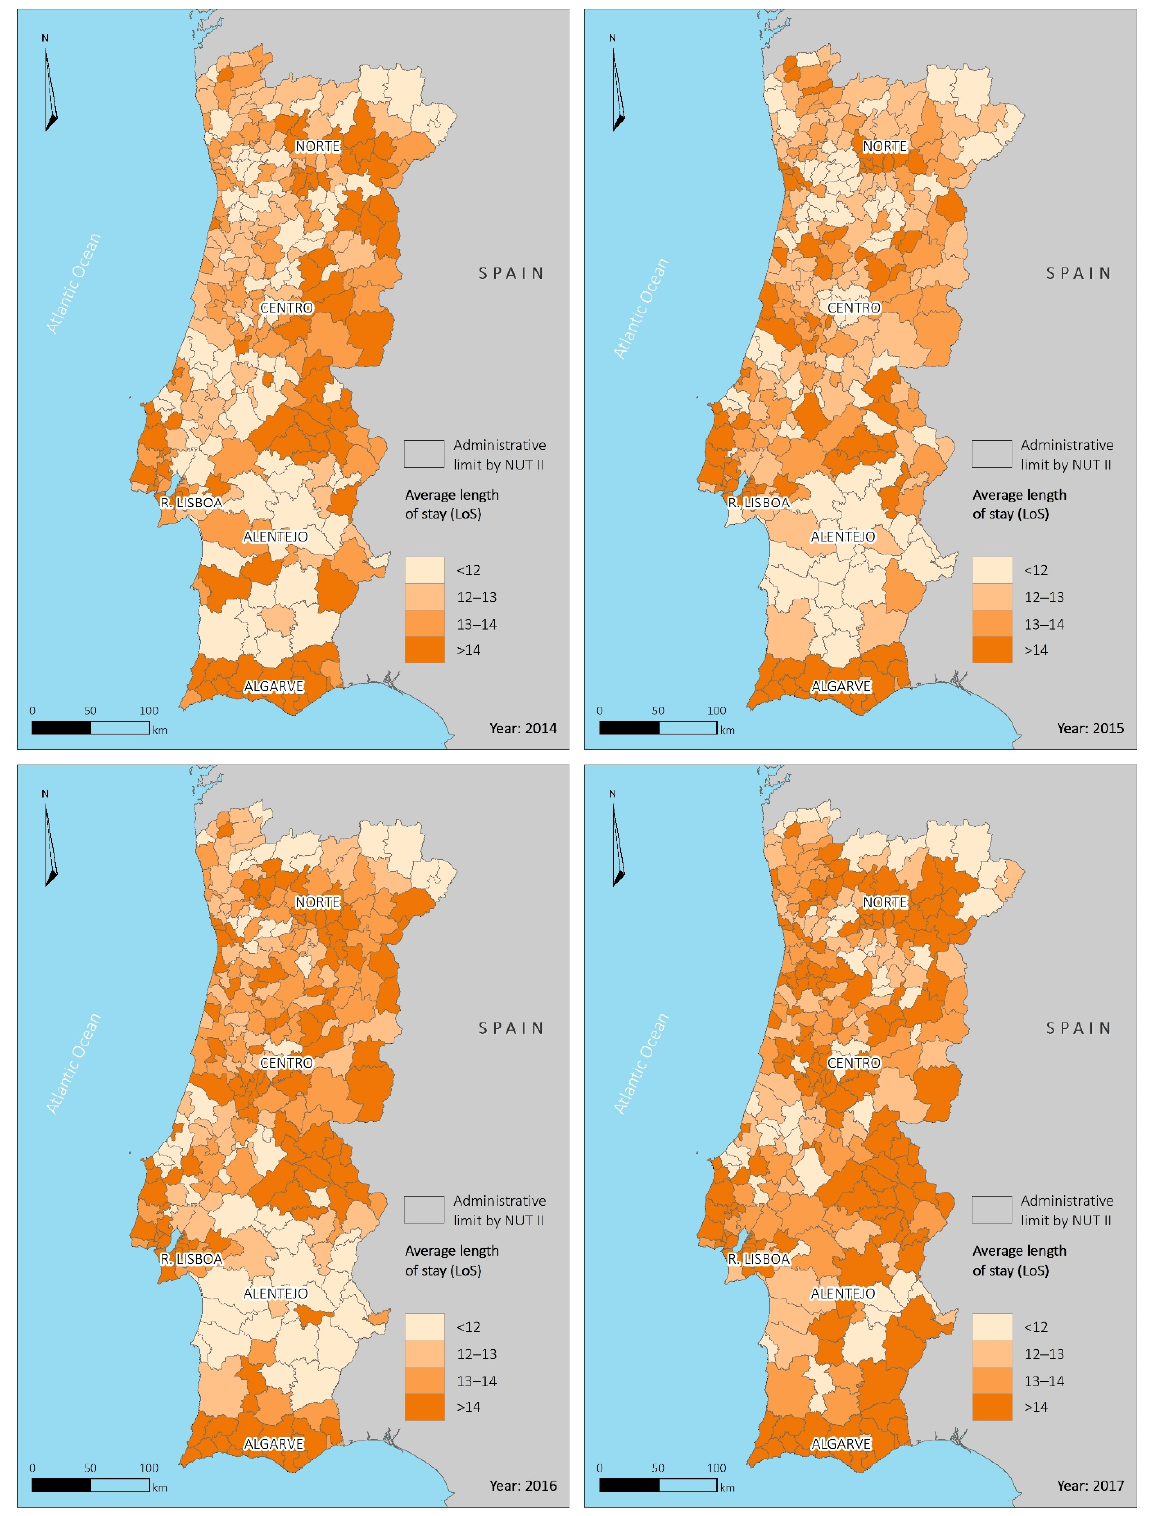
Figure 4. Spatial distribution of average length of stay of HAI hospitalization per municipality for the period 2014–2017.